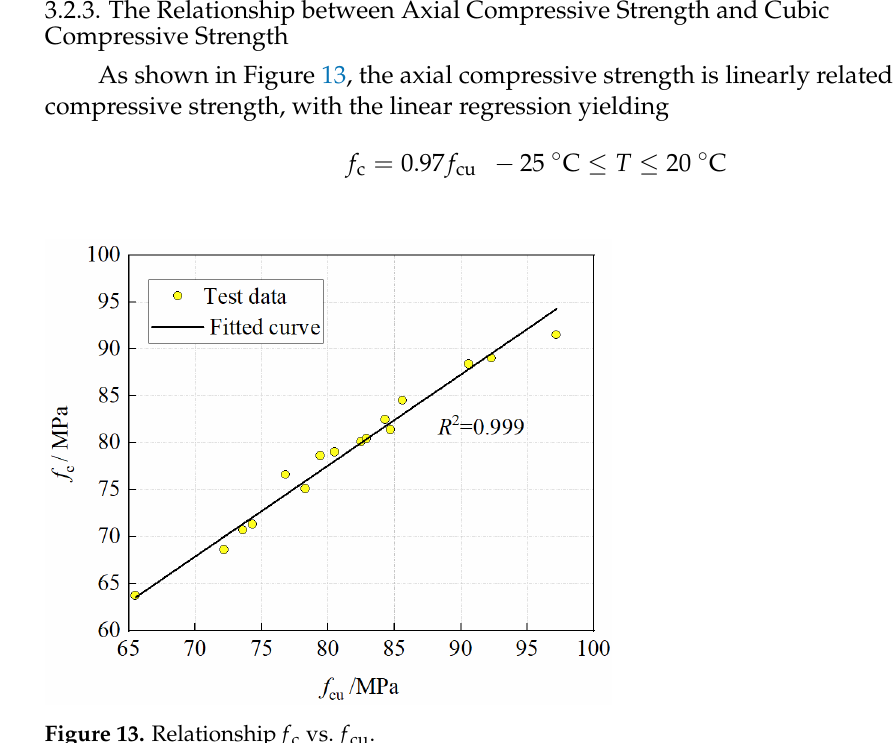
10 of 23 Figure 12. Relationship c,T η vs. T and V cf.